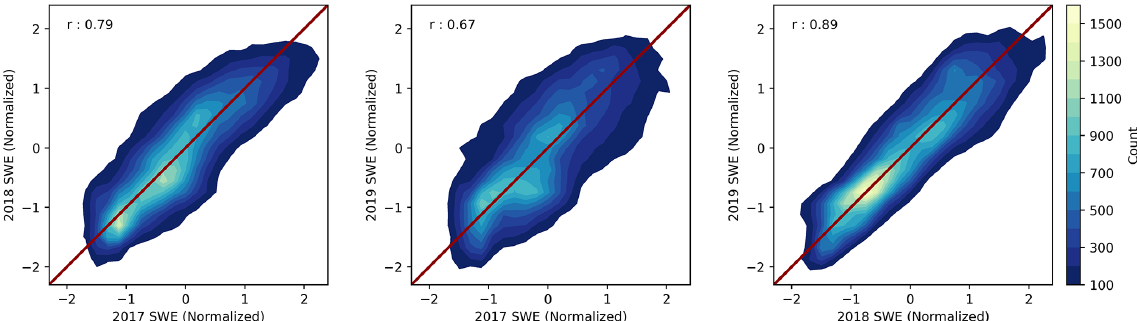
Figure 10. Heatmaps of predicted normalized SWE for Teller in 2017, 2018, and 2019, with Pearson correlation coefficients ( r ) showing significant correlations of SWE among the years. Random forest was trained with data from all years and sites. The color scale represents the density of data points, with dark blue representing areas with the least points and light yellow representing areas with the most points. Areas with fewer than 100 points are not plotted. The solid red line is a line of the best fit using singular value